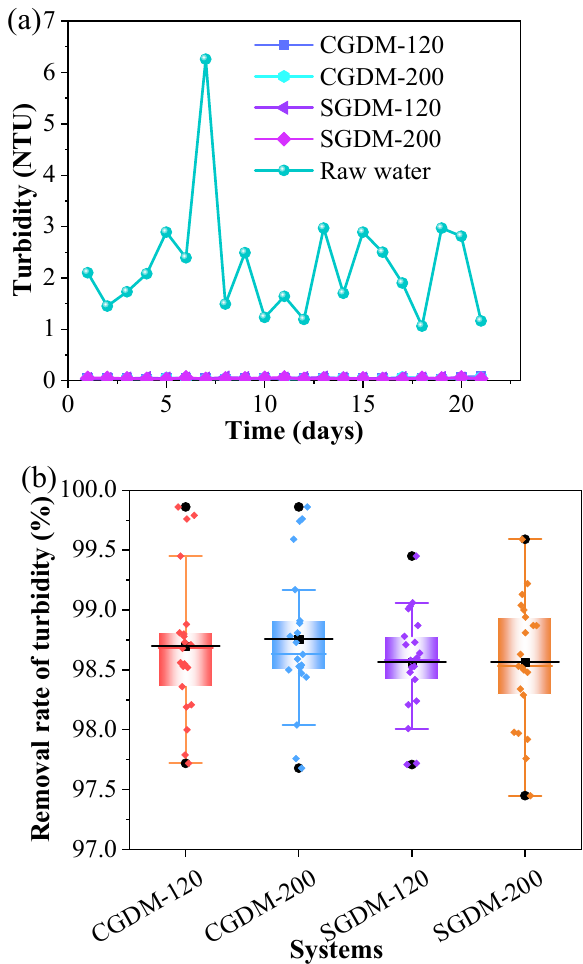
Figure 3. Removal performance of turbidity: ( a ) turbidity in effluents, ( b ) removal rate of turbidity (including average, maximum, and minimum).